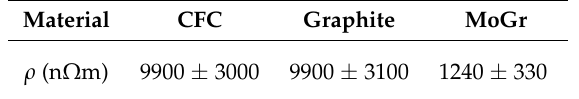
Table 5. Resistivity of CFC, graphite and MoGr measured with the four-probes method on thin